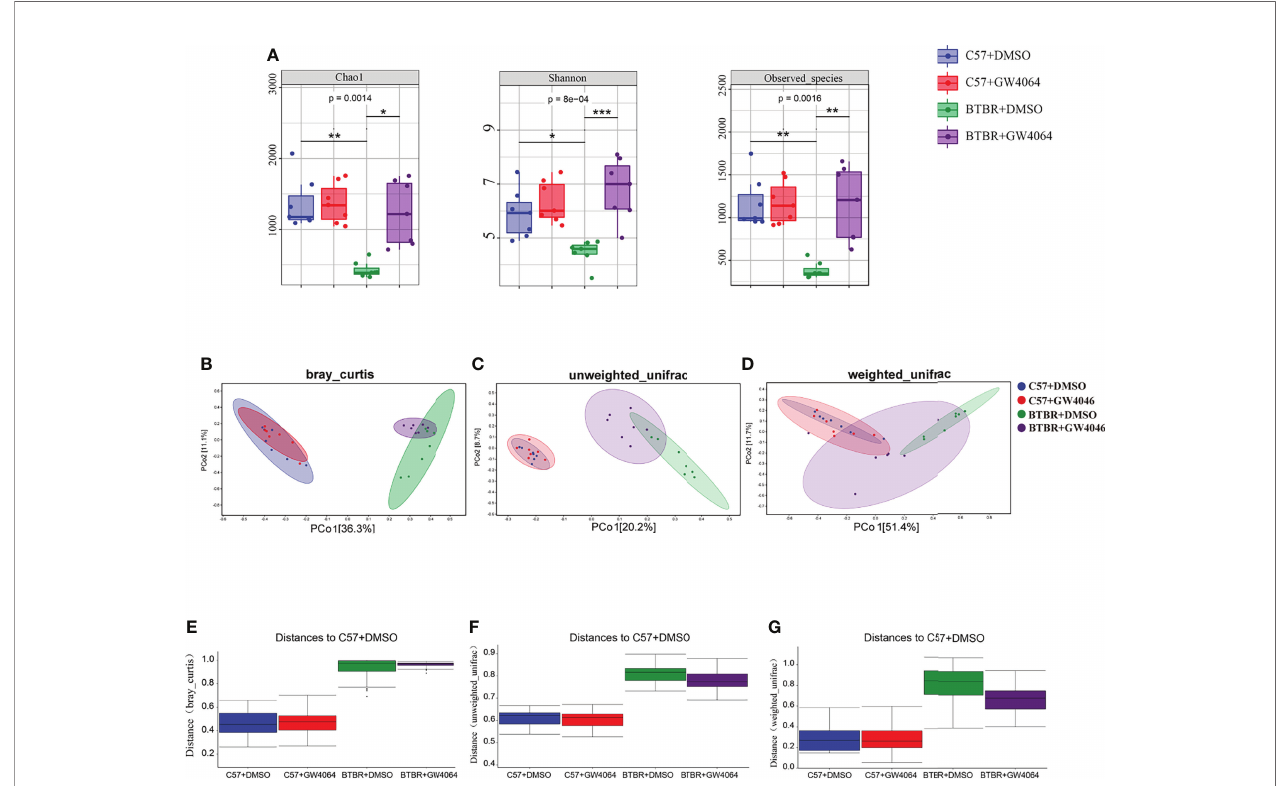
FIGURE 5 | GW4064 treatment signi fi cantly modulated the decreased gut microbiota diversity in BTBR mice. (A) GW4064 treatment altered the alpha-diversity in BTBR mouse gut microbiota analyzed with Chao1, Shannon, Observed-species index to a similar level of C57. (B – D) GW4064 treatment altered the BTBR gut microbiota principal coordinate analysis (PCoA) of the beta-diversity index to get close to C57 using Bray-Curtis(B), unweighted-unifrad(C), weighted-unifrad distances(D). Each symbol represents an individual mouse. n = 7. *p < 0.05, **p < 0.01, ***p < 0.001 (E – G) PERMANOVA statistical tests quantify the distances among groups corresponding to the Bray-Curtis(E), unweighted-unifrad (F) , weighted-unifrad distances (G)